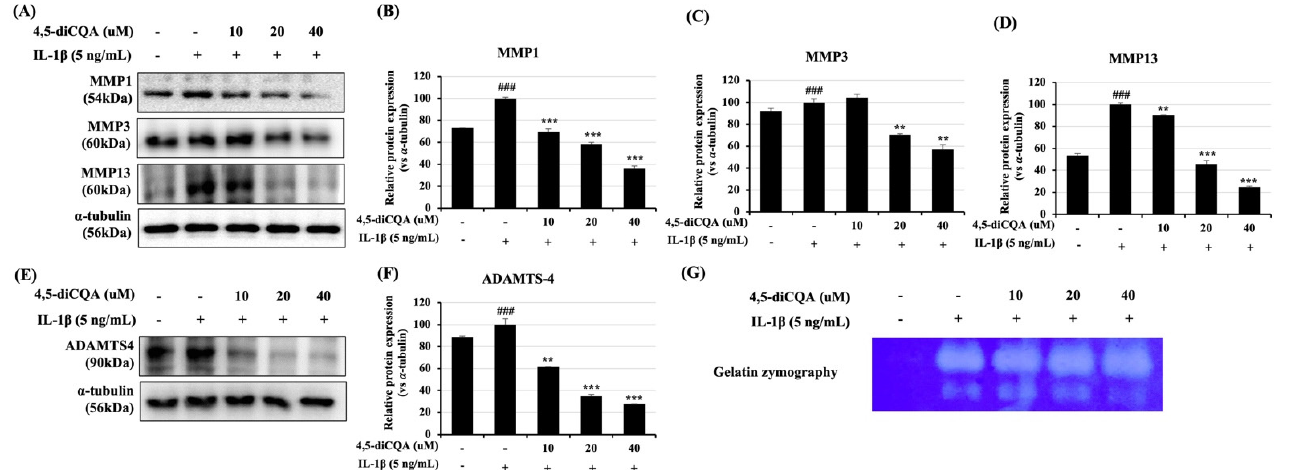
Figure 3. Inhibitory effect of 4,5 ‐ diCQA on IL ‐ 1 β‐ induced MMP ‐ 1, MMP ‐ 13, and ADAMTS ‐ 4 in rat primary chondrocytes. Cells were pre − treated with 4,5 ‐ diCQA (10, 20, and 40 μ M) for 1 h, followed by IL ‐ 1 β (5 ng/mL) stimulation for 24 h. ( A , E ) Protein levels of MMP ‐ 1, MMP ‐ 13, and ADAMTS ‐ 4 were determined using Western blot analysis. α‐ Tubulin served as an internal control. ( B – D ) Quan ‐ titative data of ( A ) were analyzed using the ImageJ bundled with Java 1.8.0_172 software. ( F ) Quan ‐ titative data of ( E ) were analyzed by using the ImageJ bundled with Java 1.8.0_172 software. ( G ) Activity of MMPs was measured in conditioned medium using gelatin zymography. Data are rep ‐ resented as mean ± SD of three independent experiments. n = 5 per group. ### p < 0.005 vs. control group; ** p < 0.05, and *** p < 0.005 compared with the IL ‐ 1 β‐ treated group.